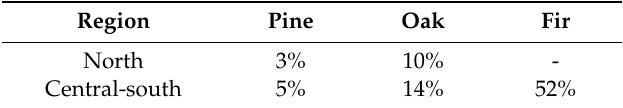
Table 15. Extraction limits for non-extracted stands constrained by mechanization